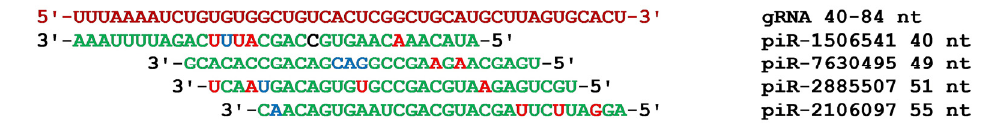
Figure 2. Localization of piRNA BSs clusters in the gRNA of the Omicron variant of SARS ‐ CoV ‐ 2.